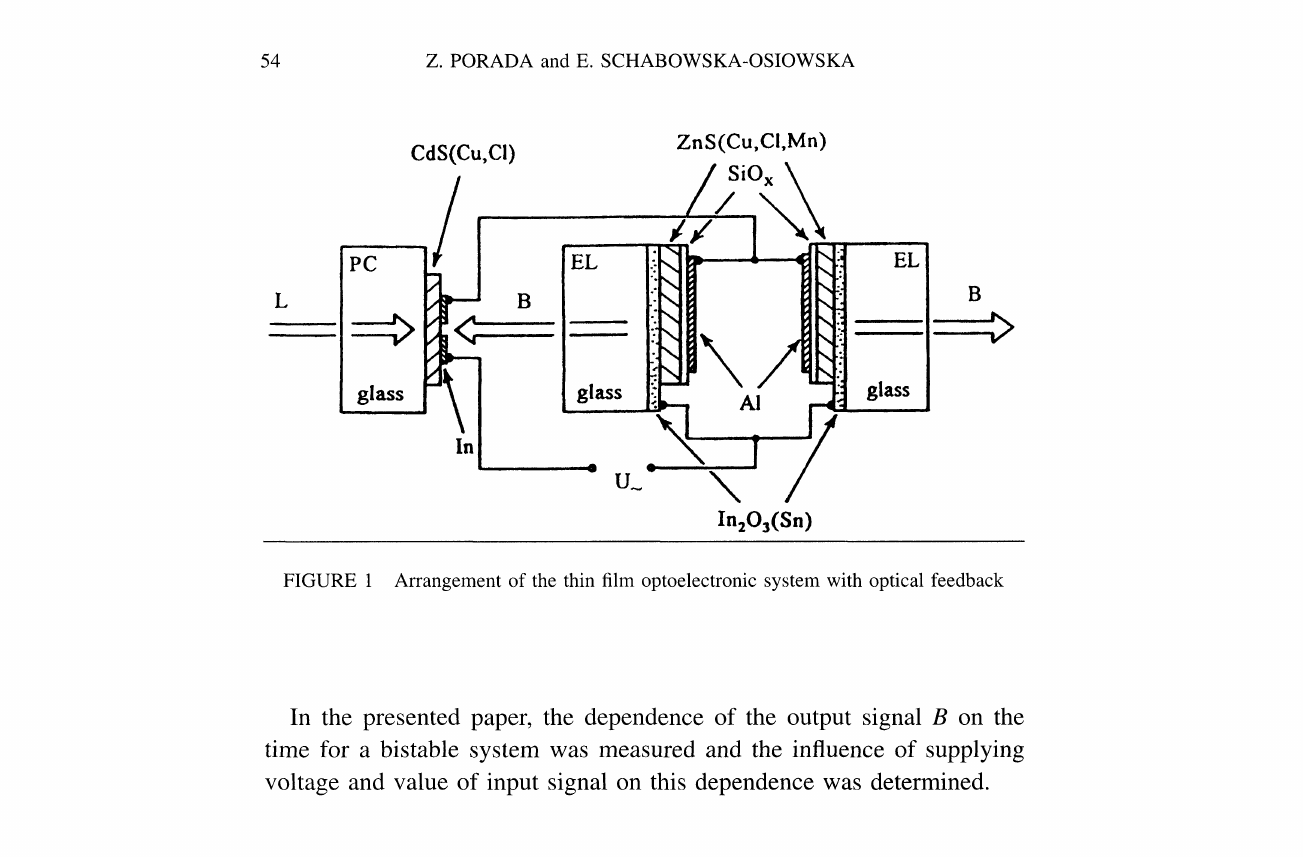
Arrangement of the thin film optoelectronic system with optical